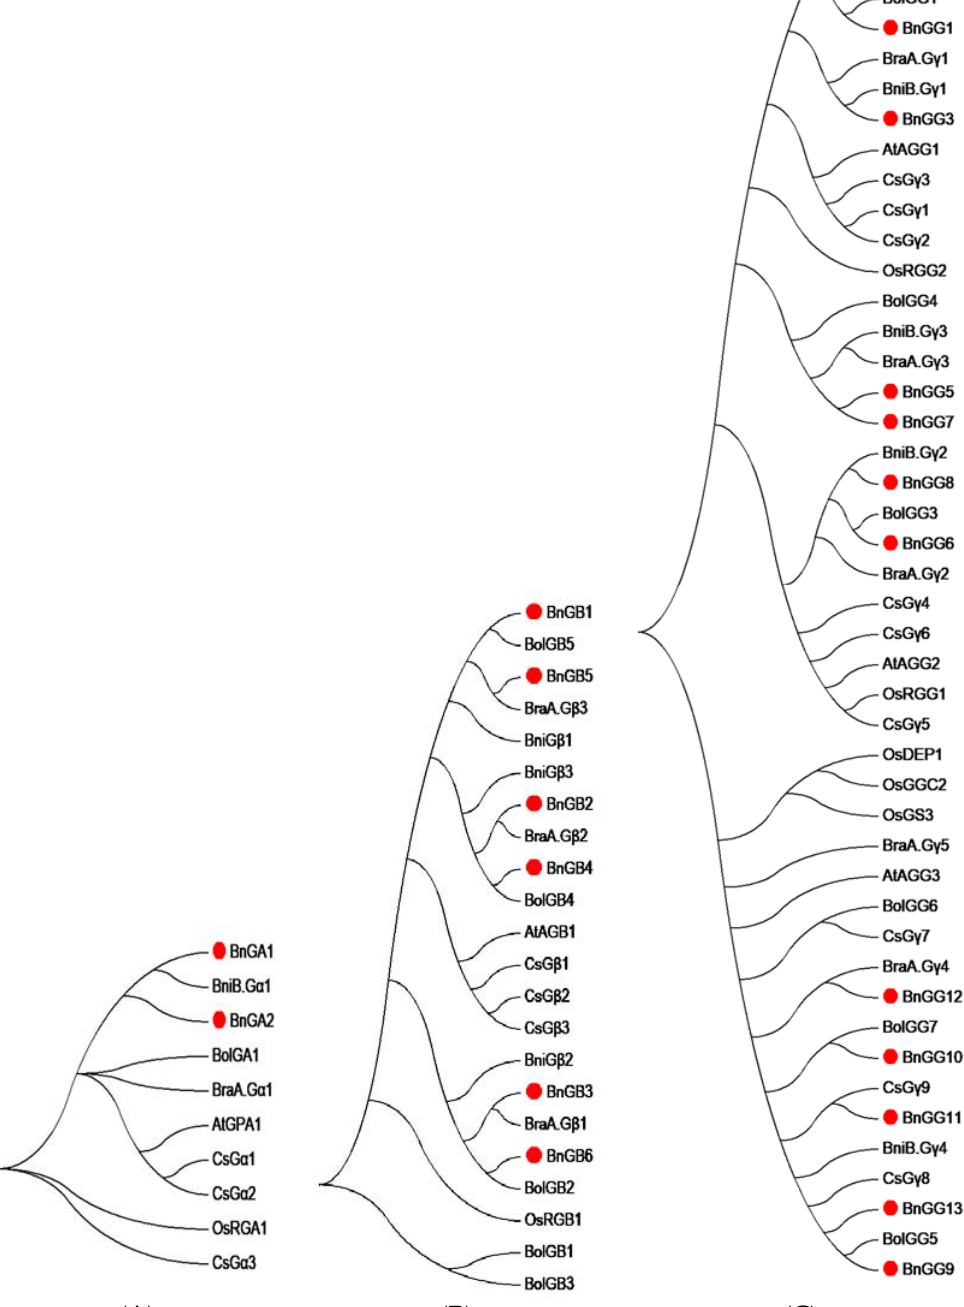
Figure 2. Evolutionary relationship of B. napus G ‐ protein. The phylogenetic analysis of ( A ) G α , ( B ) G β , and ( C ) G γ proteins isolated from B. napus , with their corresponding G ‐ protein subunit proteins in B. rape ( Bra ), B. oleracea ( Bol ), B. nigra ( Bni ), Arabidopsis ( At ), Oryza sativa ( Os ) and Camelina sativa ( Cs ), was performed using the neighbor ‐ joining method in MEGA 7.0, with 1000 bootstrap replications. The red dots represent B. napus G ‐ protein.